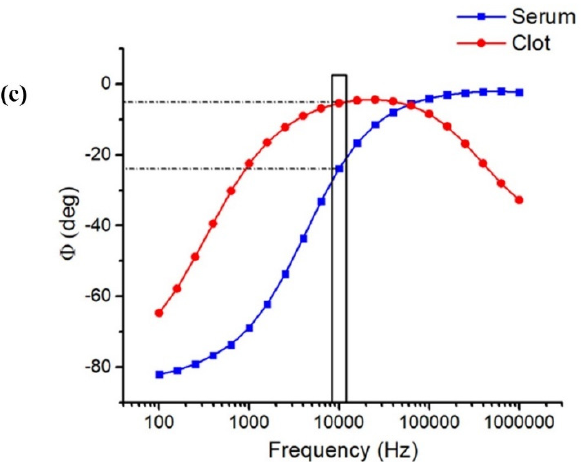
Figure 4. ( a ) Electric-field lines in blood at low frequency (kHz) and high frequency (MHz). ( b ) Impedance phase angle ( Φ ) as a function of time for recalcified blood; the red arrows indicate the value of Φ before and after the steep increase. ( c ) Impedance-phase broadband spectroscopy (100 Hz–1 MHz) of clot and serum separated after retraction.